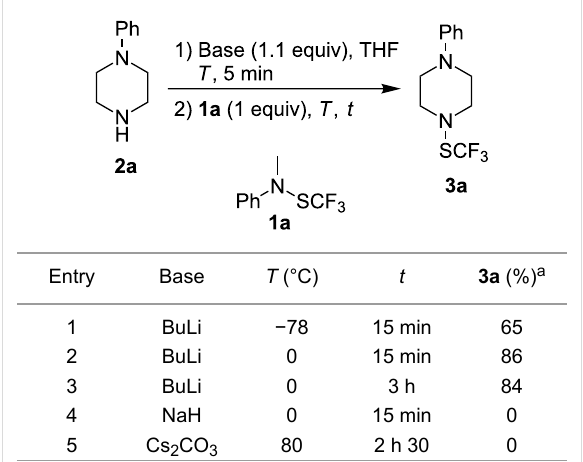
Table 1: Reaction of phenylpiperazine ( 2a ) with 1a under basic condi-